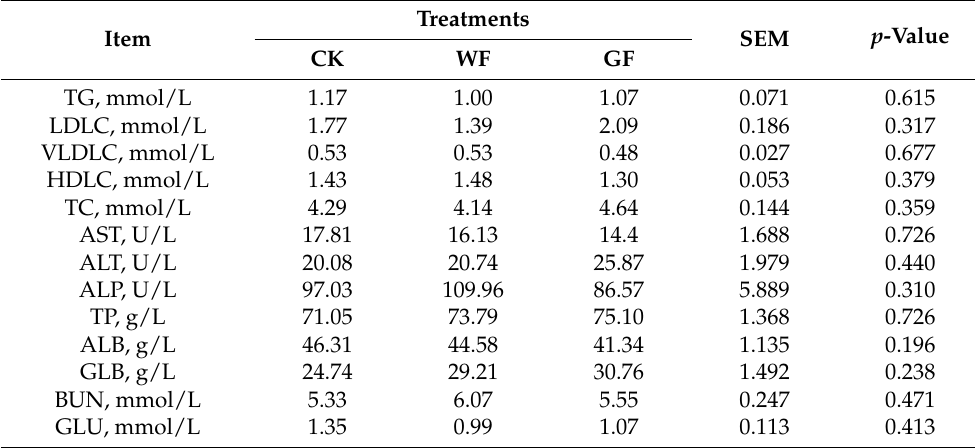
Table 7. Plasma parameters of dairy cows in different groups.